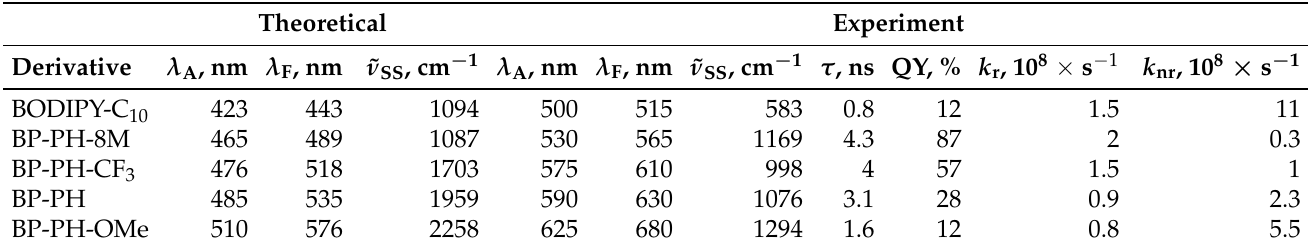
Table 1. Theoretically calculated and experimental values of the peak maxima of absorption ( λ A ) and fluorescence emission ( λ F ) spectra, as well as Stokes shifts (˜ ν SS ) for investigated derivatives in toluene. Experimental values of fluorescence lifetime ( τ ), quantum yield (QY), radiative ( k r ), and non-radiative ( k nr ) decay rates in toluene are also